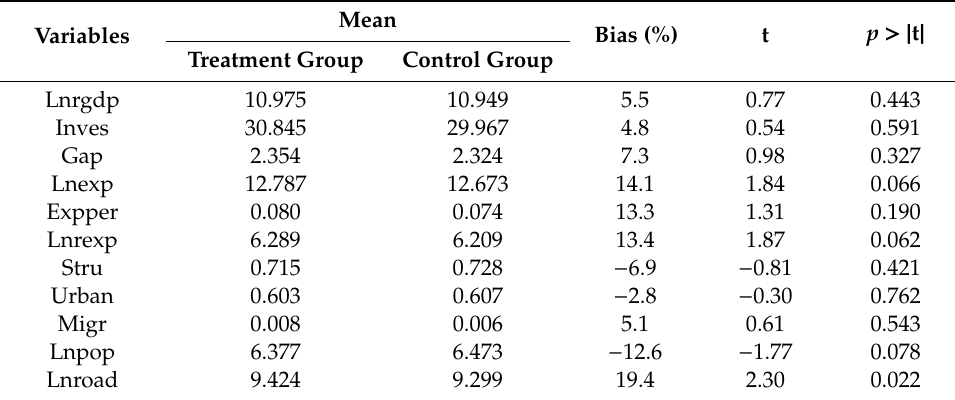
Table 10. Balance test of the PSM.